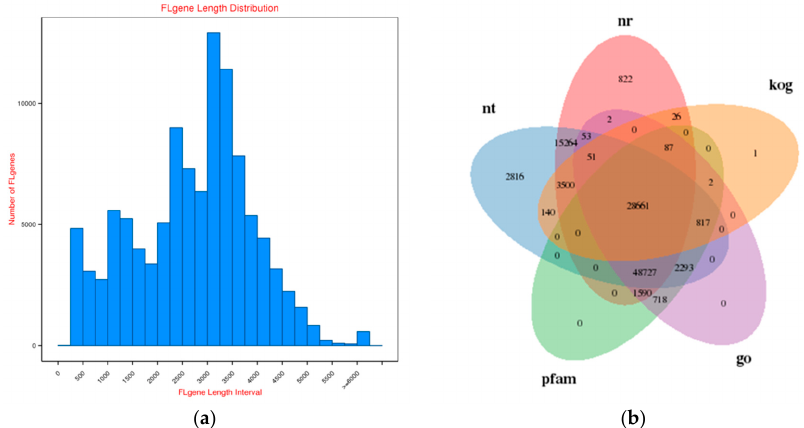
Figure 2. Full-length gene from SMRT sequencing and their annotation in main database. ( a ) The length distribution of full-length gene. Horizontal axis indicates the different length interval of full-length; vertical coordinates indicate the number of full-length transcripts. ( b ) Gene annotation of full-length gene against main databases, including Nucleotide Sequence Database, Nt; Non-Redundant Protein Sequence Database, Nr; Protein families and domain database, Pfam, Gene Ontology, GO, and euKaryotic Orthologous Groups database, KOG.